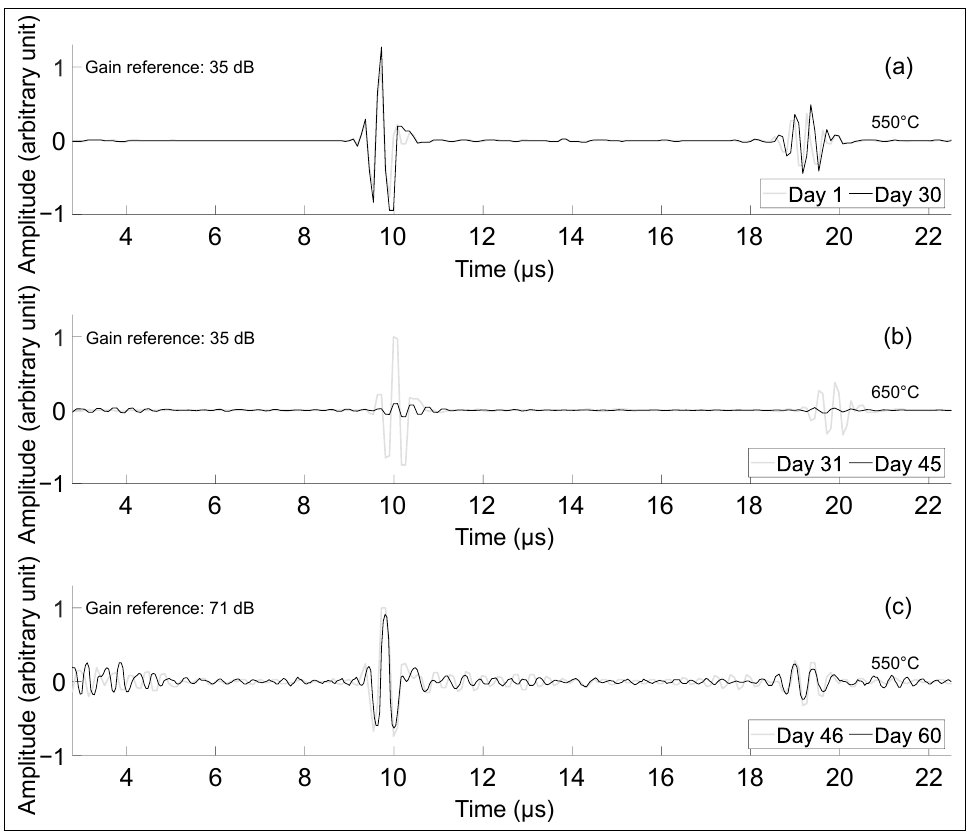
Figure 10. Transducer performance is maintained during long-term high-temperature exposure: ( a ) echoes on day 30 taken at 550 ◦ C (550 ◦ C for 30 days), ( b ) echoes on day 44 taken at 650 ◦ C (550 ◦ C for 30 days followed by 650 ◦ C for 14 days) and ( c ) echoes on day 68 taken at 550 ◦ C (550 ◦ C for 30 days followed by 650 ◦ C for 14 days followed by 550 ◦ C for 14